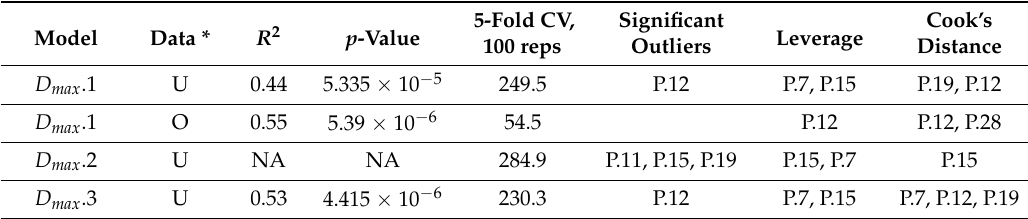
Table 5. Results of the fitted models for D max .